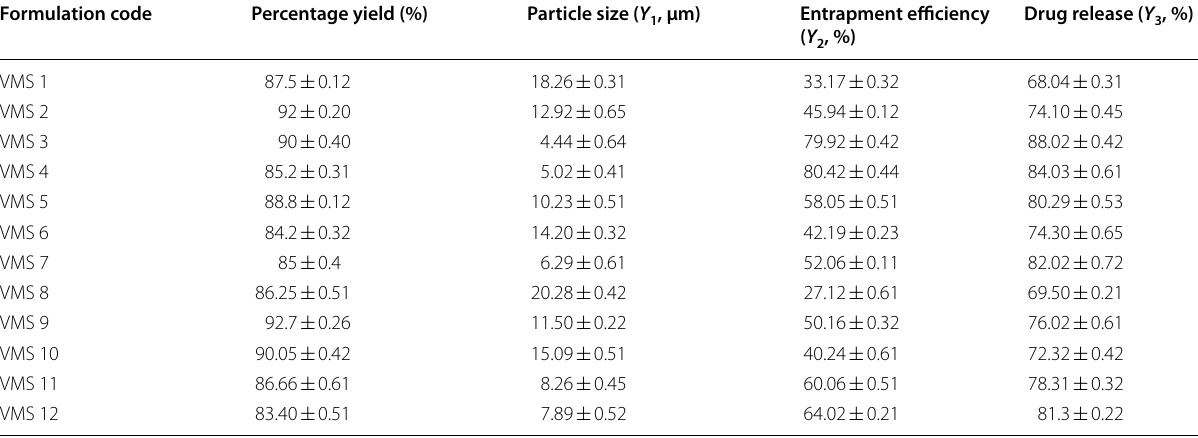
Data are represented as mean VMS Vancomycin HCl